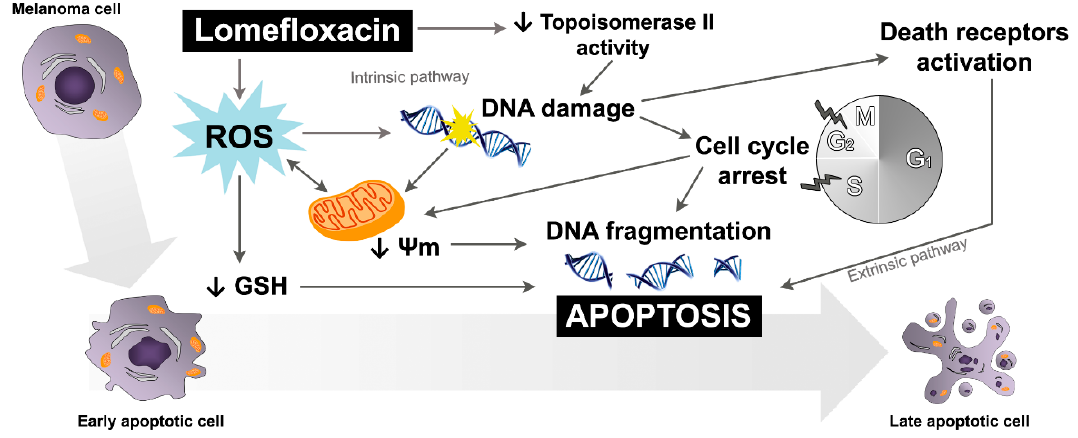
Figure 9. Schematic diagram showing the potential mechanism underlying apoptosis induction in COLO829 melanoma cells by lomefloxacin; Ψ m—mitochondrial transmembrane